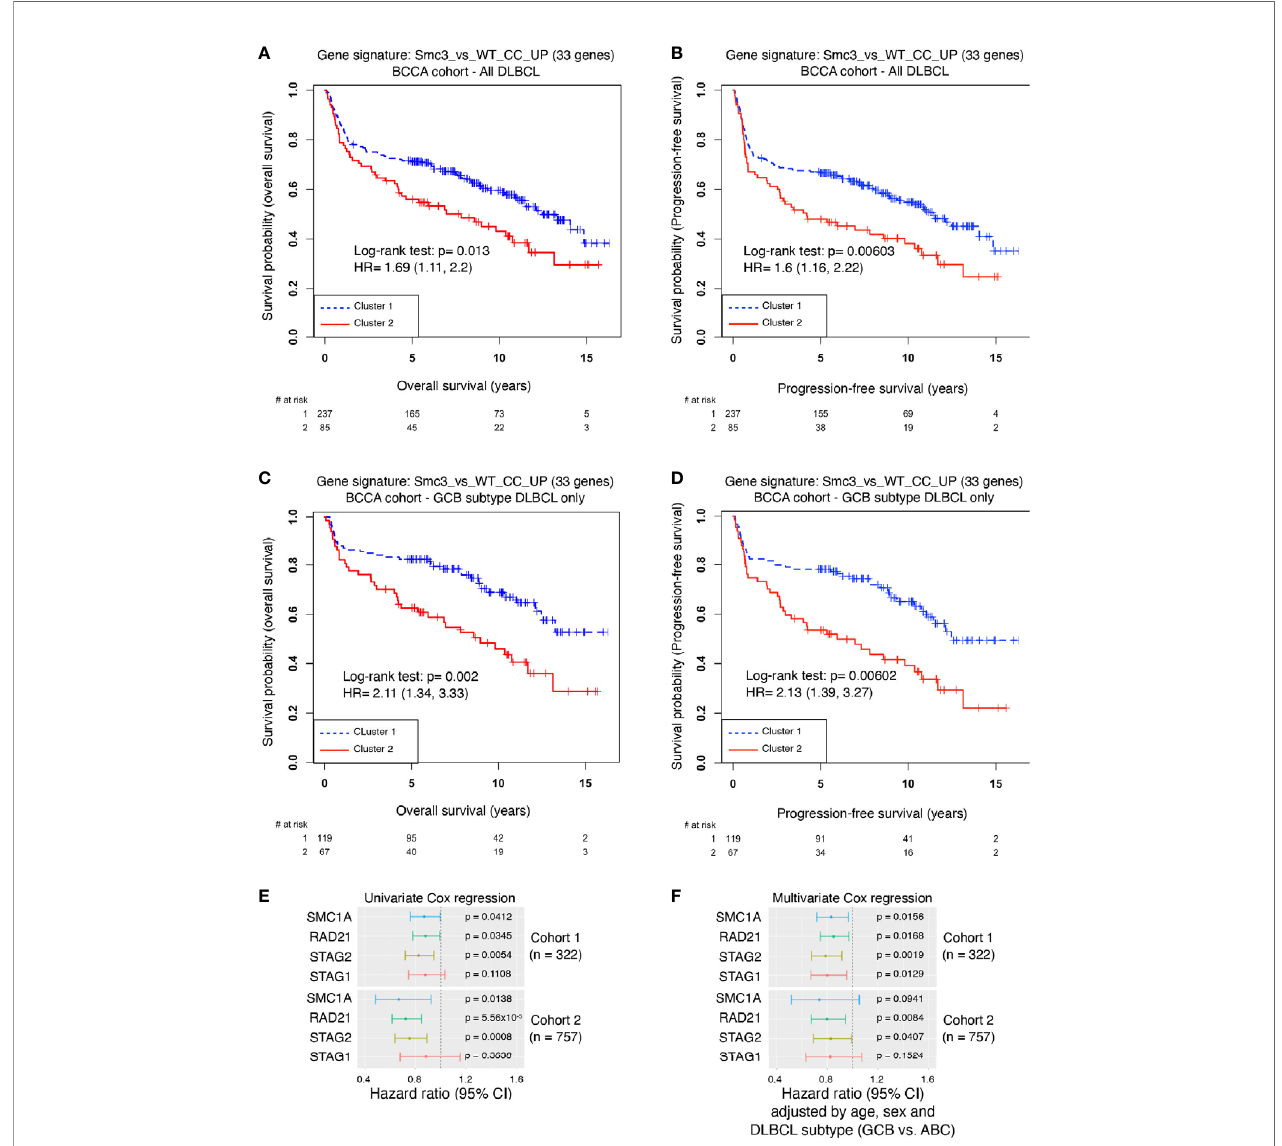
FIGURE 6 | Decreased cohesin levels predict poor survival in DLBCL patients. (A) Kaplan-Meier overall survival curves for DLBCL patients (n=322) in BCCA cohort clustered with the Smc3 haploinsuf fi cient gene signature (6). (B) Kaplan-Meier progression-free survival curves for DLBCL patients (n=322) in BCCA cohort clustered with the Smc3 haploinsuf fi cient gene signature (6). (C) Kaplan-Meier overall survival curves for GCB-subtype DLBCL patients (n=186) in cluster 1 and 2. (D) Kaplan- Meier progression-free survival curves for GCB-subtype DLBCL patients (n=186) in cluster 1 and 2. (E) Univariate Cox regression analysis, and (F) multivariate Cox regression analysis were performed in two cohorts of DLBCL patients (cohort 1, n = 322 individuals; cohort 2, n = 757 individuals). In both cases, SMC1A , RAD21 , STAG2 and STAG1 expression levels were used as a continuous variable. Multivariate analysis was adjusted by age, sex and DLBCL subtype of the individual. Error bars represent 95% con fi dence intervals of the hazard